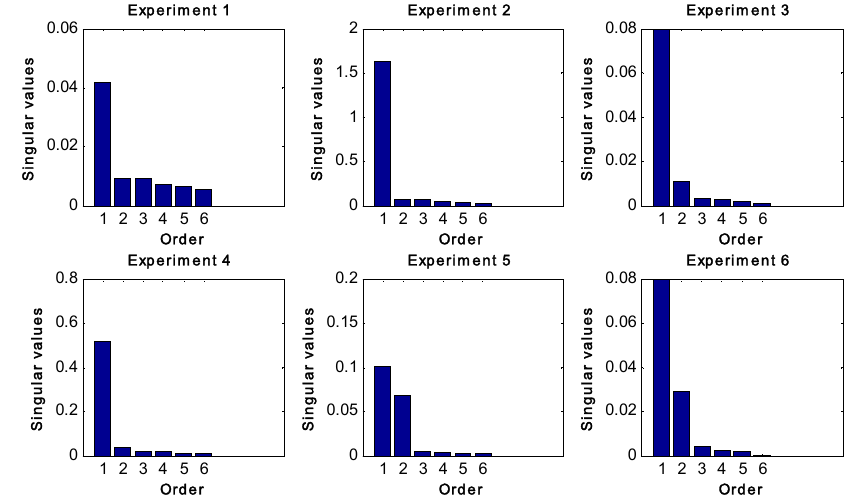
Figure 4. Order estimation for 2 × 2 distillation column using adaptive DOE with rotated PRBS inputs. A cut-off point is evident at